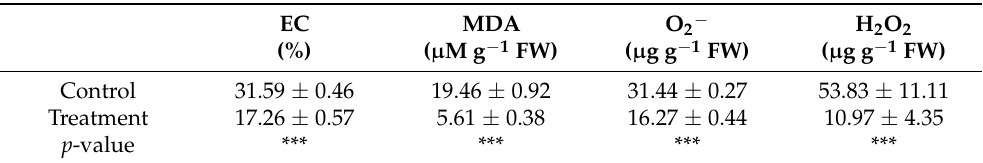
Table 4. EC percentage and MDA, O 2 − , and H 2 O 2 concentrations in control plants and plants treated with Archer ® Eclipse.